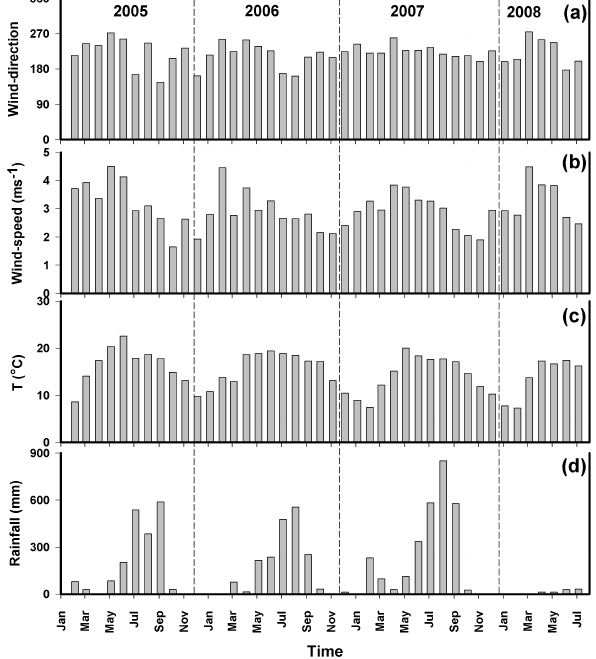
Fig. 2. The monthly average meteorological data for rain fall, tem- perature, wind speed and wind-direction during the sampling period (February 2005–July